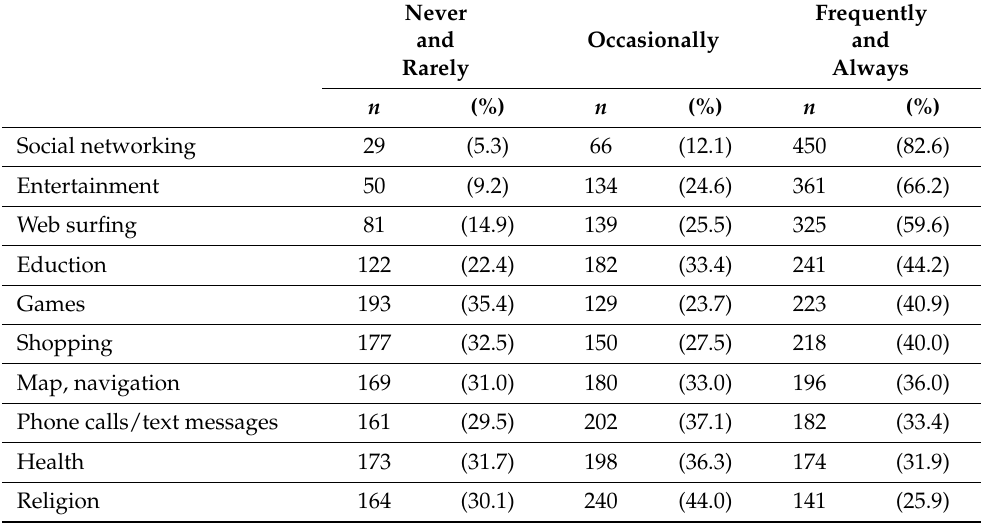
Table 3. Distribution of the purpose of daily smartphone use, N = 545.